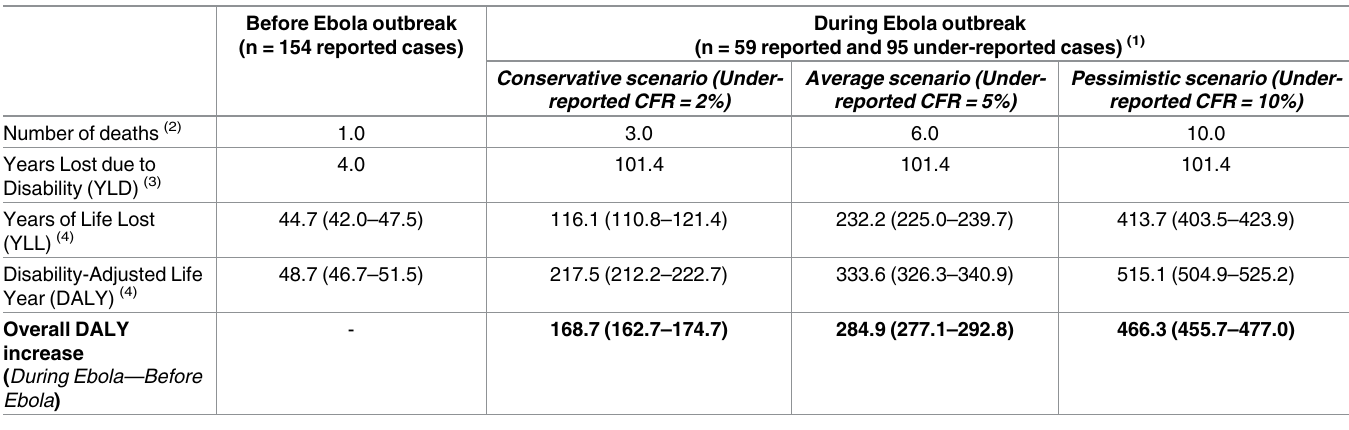
Table 2. Disability-Adjusted Life Years (DALY) estimatesfor HAT cases before and during Ebola outbreak, Guinea (January 2012 to October